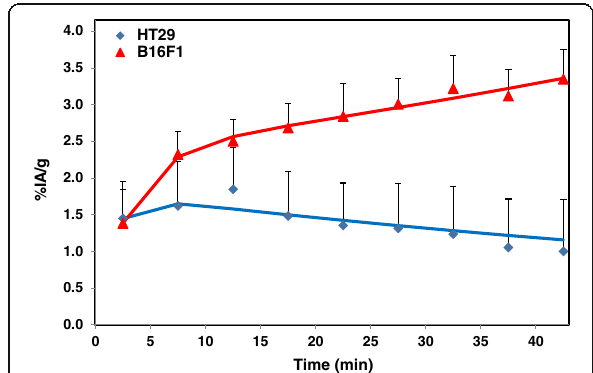
Fig. 8 Time activity curves showing tumor uptake in mice bearing B16F1 and HT-29 tumors. The curves were generated from microPET images. Each data point represents the percent of injected Activity per gram (%IA/g) of B16F1 tumor ( red ) and HT-29 ( Blue ) at various time points after injecting 4-[ 18 F]FEBZA. After an initial accumulation in both the tumor, the uptake levels in melanoma tumor increased with time ( red ), whereas the levels in HT-29 tumor decreased and remained low ( blue